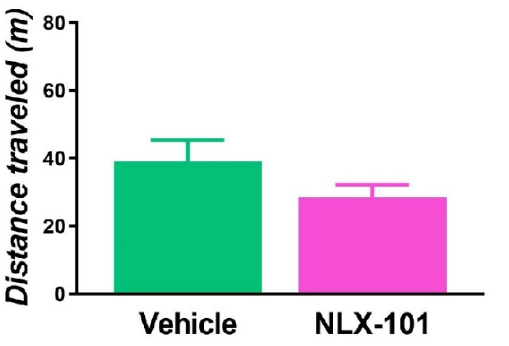
Figure 2. Behavioral response in the open field test (OFT). Locomotor activity after the administration of 0.16 mg/kg of NLX-101 is expressed as distance traveled in meters during 10 min. Results are expressed as mean ± SEM of n = 5–6 rats per group.